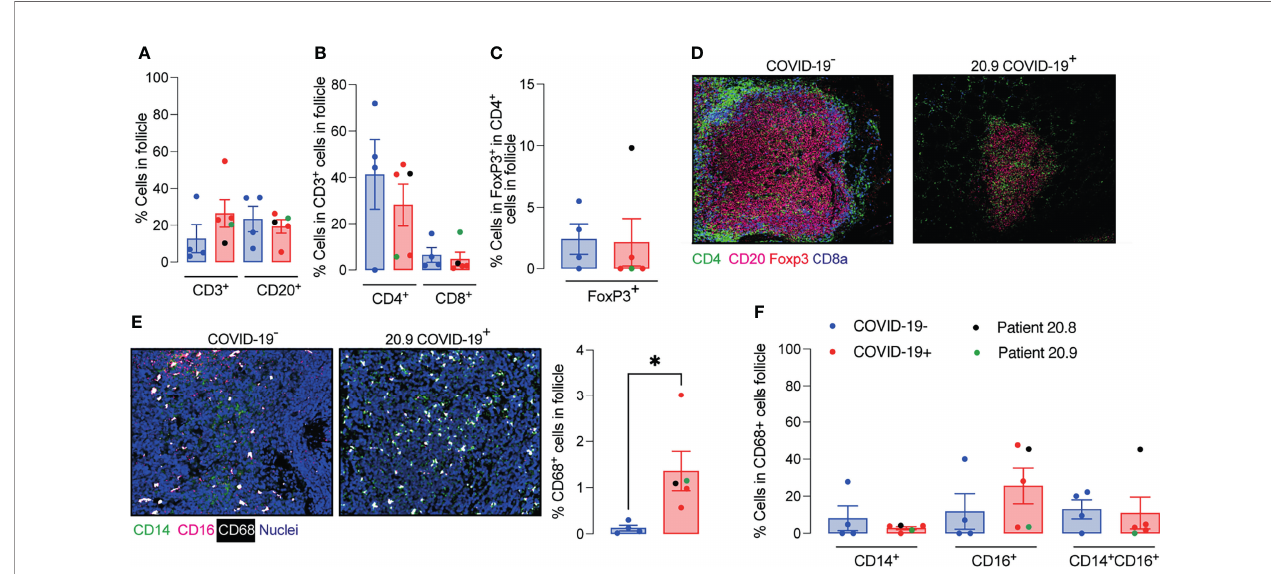
FIGURE 3 | Enhanced relative numbers of macrophages in ileal follicles in Peyer ’ s patches (PP) of COVID-19 patients. (A-C) Percentages of follicular T and B cells, CD4 + , CD8 + and CD4 + FoxP3 + T cells in ileal Peyer ’ s Patch (PP) from COVID-19 - and COVID-19 + patients. (D) Representative images from histoCAT showing CD4 (green), CD8a (blue), FoxP3 (red) and CD20 (magenta) signals in PPs. (E) Representative images from histoCAT showing CD68 (white), CD14 (green) and CD16 (magenta) signals in PPs on the left, and mean CD68 signals on the right. (F) Percentages of follicular CD14 + , CD16 + and CD14 + CD16 + cells from CD68 + cell population. Data is shown as mean ± SEM. (n = 4 controls and 5 patients). Kruskal-Wallis followed Dunn ’ s post-test in (D) and two tailed Mann-Whitney t test in (E) . *P < 0.05.